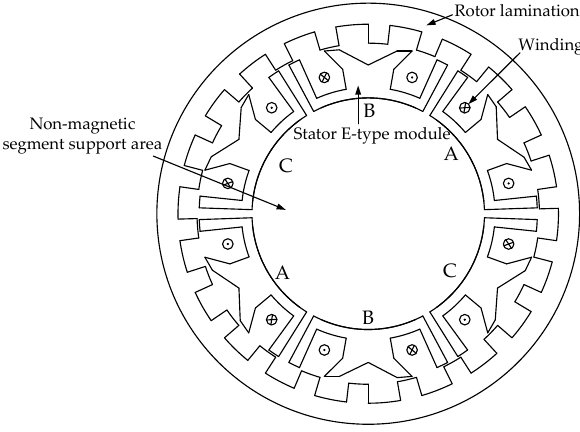
Figure 10. Improved 9/12 pole E-type module SRM [39].